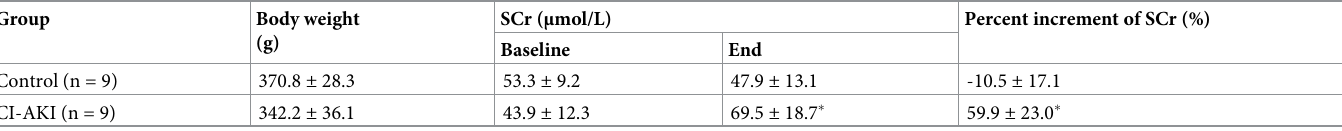
Data are mean ± SD. Statistical analysis was performed using Student’s t test. �